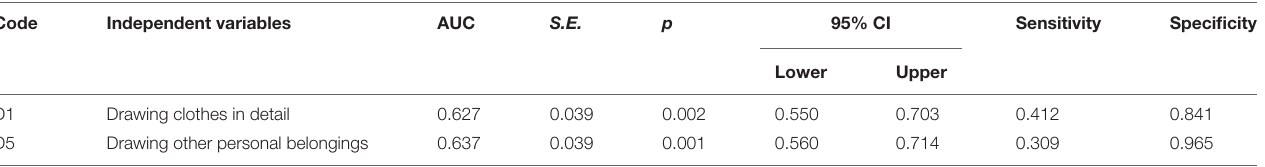
TABLE 6 | Results of ROC curve analysis of drawing features negatively associated with